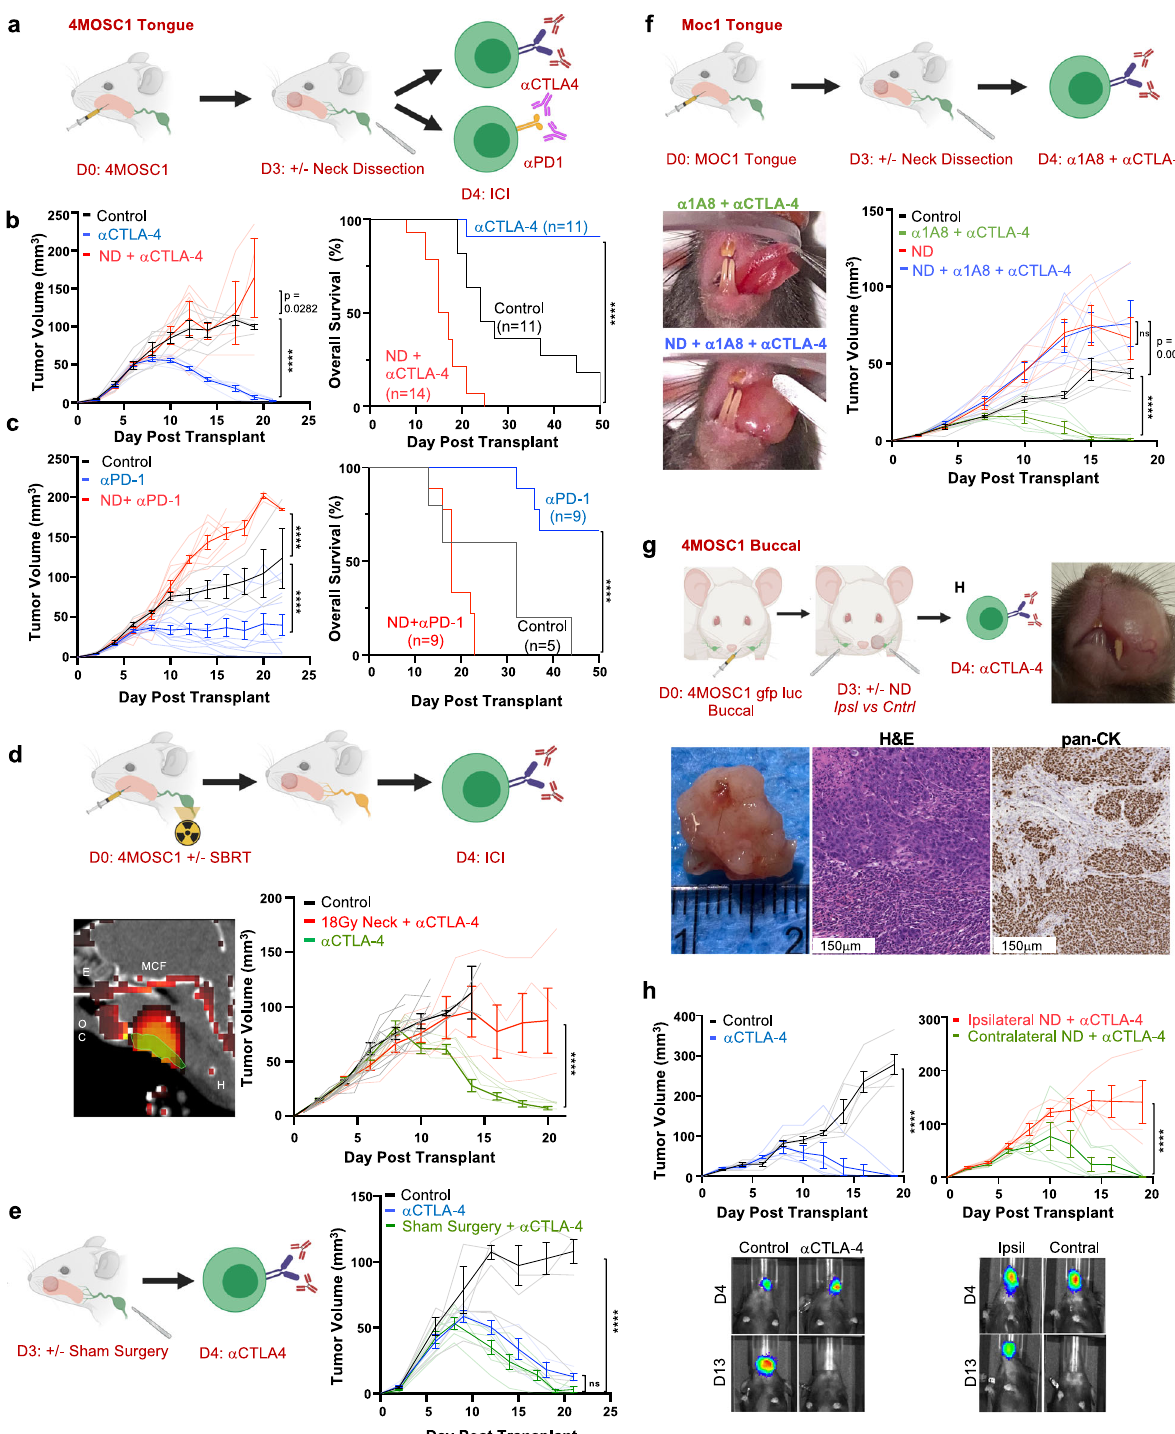
(Supplementary Fig. 2B), in 4MOSC1-tongue tumor-bearing animals blocked the tumor response to α CTLA-4 ICI (Fig. 2d). To control for any confounding effects of surgery on the tumor response to therapy, we performed either sham mock lymphatic ablations to the neck or subtotal primary tumor resections fol- lowed by treatment with ICI. Neither sham neck surgery nor subtotal primary tumor surgeries in fl uenced the response to ICI in vivo (Fig. 2e and Supplementary Fig. 2D). To demonstrate generalizability across syngeneic, orthotopic models of murine HNSCC, we employed the MOC1 preclinical HNSCC model